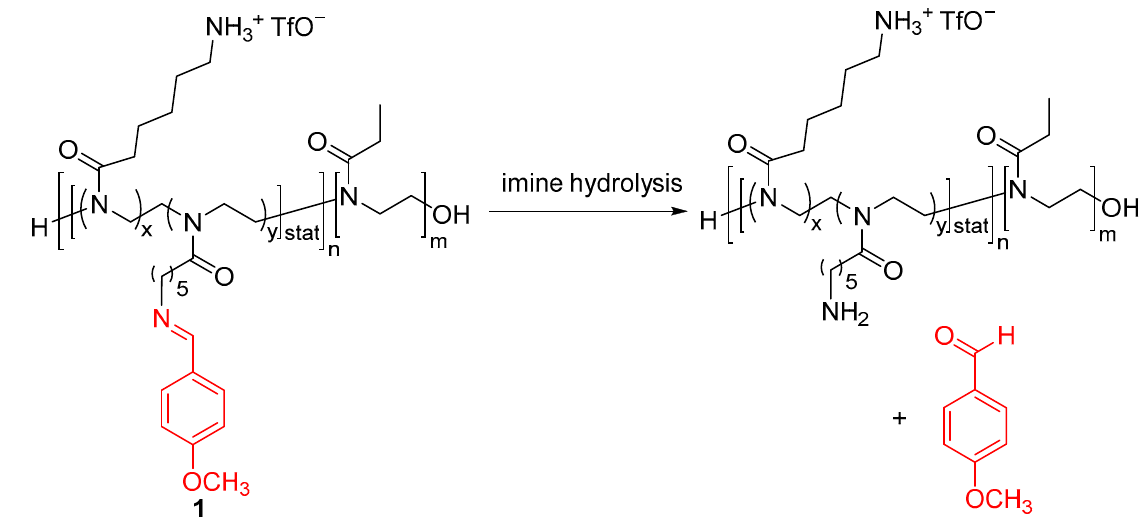
Figure 1. Release of target scent from polymeric profragrances 1 which form micelles in water. The precursor of p -anisaldehyde is highlighted. The original results were reported by Jiang and coworkers [27].